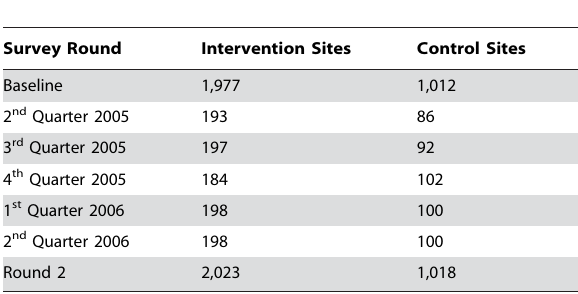
Table 1. Sample size of patient exit interviews by intervention and control